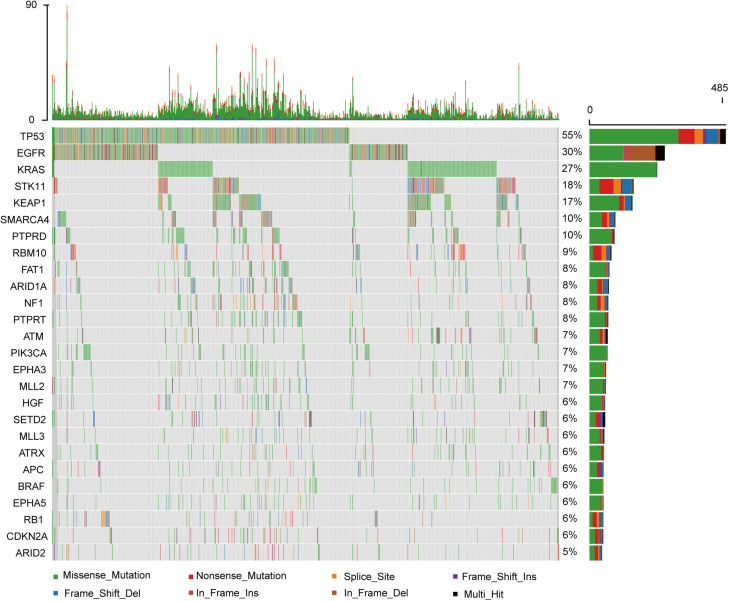
The genomic landscape and the mutation signature of advanced lung adenocarcinoma in the MSKCC database.